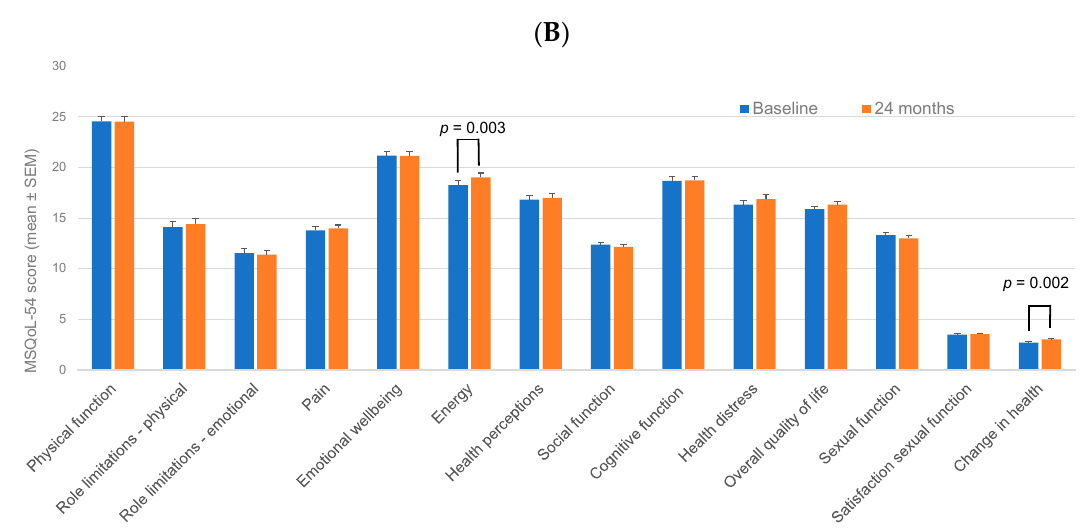
Figure 2. MSQoL-54 scores at Month 12 ( A ) and Month 24 ( B ) compared with baseline. Graphed values show mean ± SEM for each component of the MSQoL-54 test. Statistically significant outcomes from paired sample t -test results at 12 months ( A ) and 24 months ( B ) versus baseline are shown. SEM: standard error of the mean.